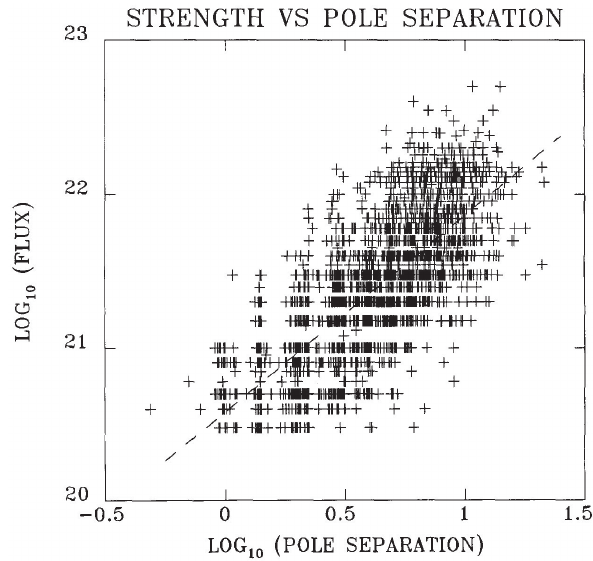
Figure 5: Relationship (log-log) between magnetic flux (in Mx) of the leading spot in bipolar regions in the period 1976 – 1986 and polarity separation ( 𝑠 ) in heliographic degrees. A least-square fit to the data (dashed line) defines a relationship as Φ( 𝑠 ) = 4 × 10 20 Mx s 1 . 3 . Image reproduced with permission from Wang and Sheeley Jr (1989), copyright by